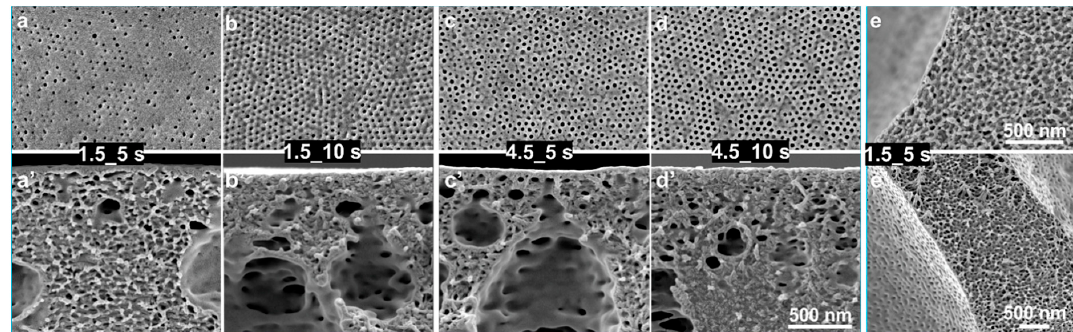
Figure 8. SEM micrographs of the top surfaces ( a – d ) and the surfaces of cross-sections ( a’ – d’ ) of the flat sheets cast using block copolymer solution of 24 wt% PS- b -P4VP 18150 in DMF/THF 3/7 (wt/wt). As mentioned on the micrographs, the casting parameters were Q g of 1.5 and 4.5 L/min for t g of 10 and 20